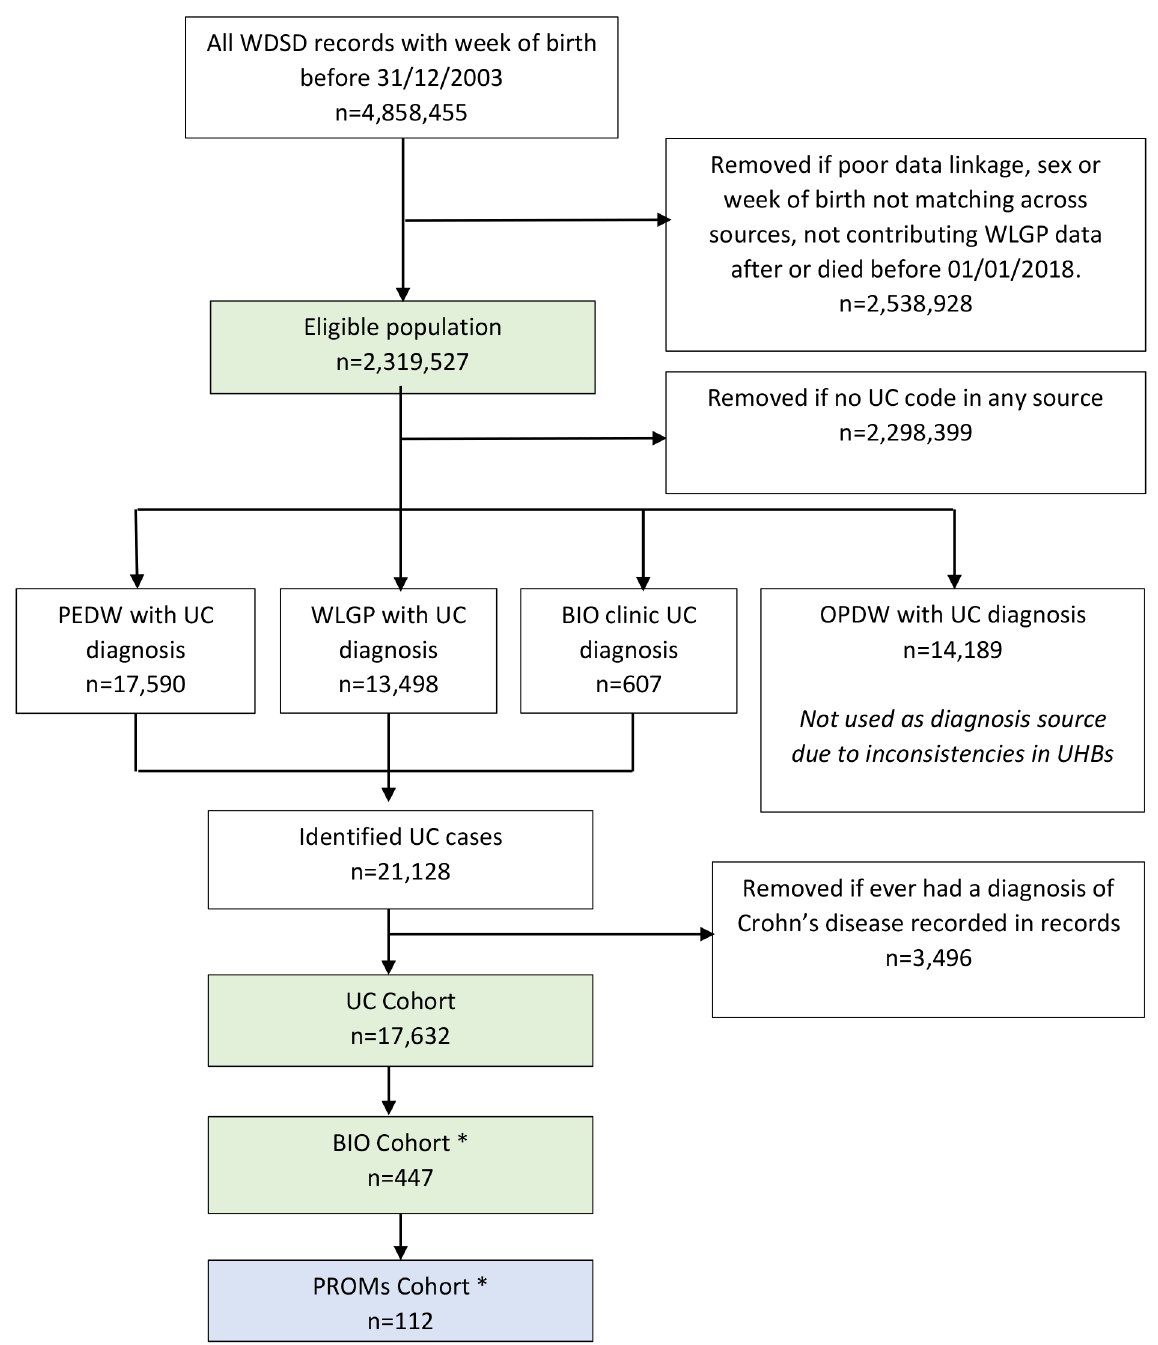
Figure 1: STROBE diagram outlining the steps completed for the cohort selection and data cleansing from the multiple data sources